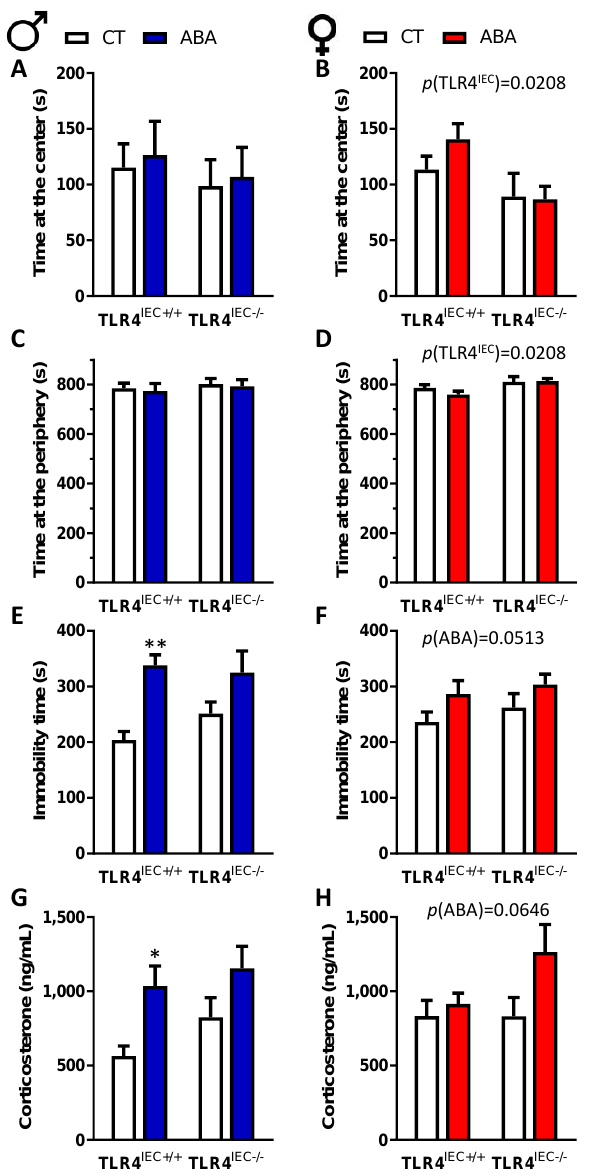
Figure 5. Open field test at d17 and corticosterone plasma levels in male and female mice. Time at the centre ( A ), the periphery ( C ) and immobility time ( E ) during open field test and corticosterone plasma level ( G ) between TLR4 IEC+/+ and TLR4 IEC − / − in CT (open bars) and ABA (blue bars) male mice. Time at the centre ( B ), the periphery ( D ) and immobility time ( F ) during open field test and corticosterone plasma level ( H ) between TLR4 IEC+/+ and TLR4 IEC − / − in CT (open bars) and ABA (reds bars) female mice. The results of the Bonferroni post hoc tests are shown: *, p < 0.05 and **, p < 0.001 vs. CT; p < 0.05 vs. TLR4 IEC+/+.